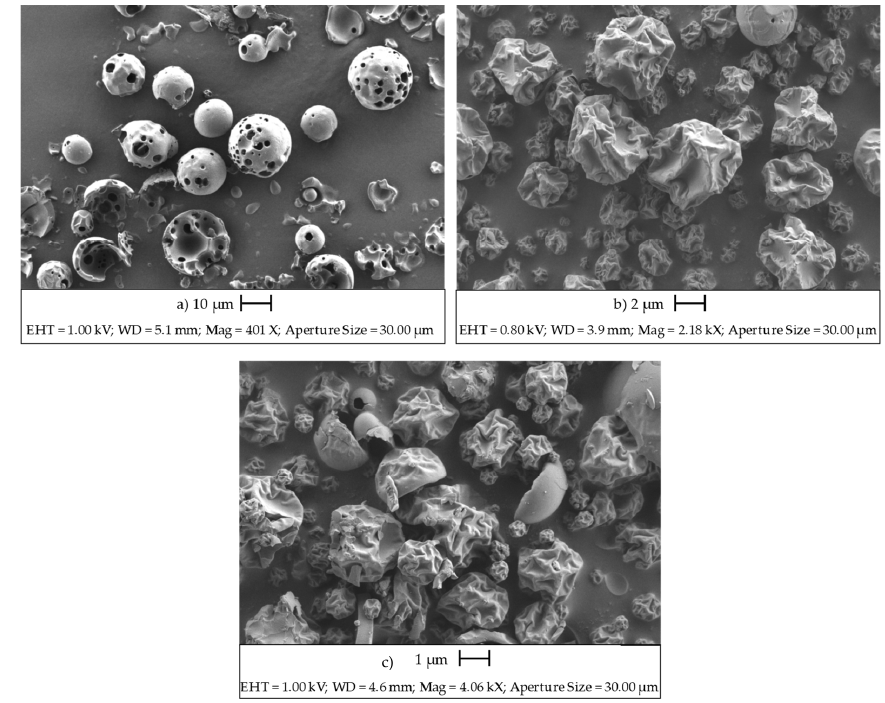
Figure 4. Micrographies of HP- β -CDs ( a ), MWI complexes ( b ), and US complexes ( c ).